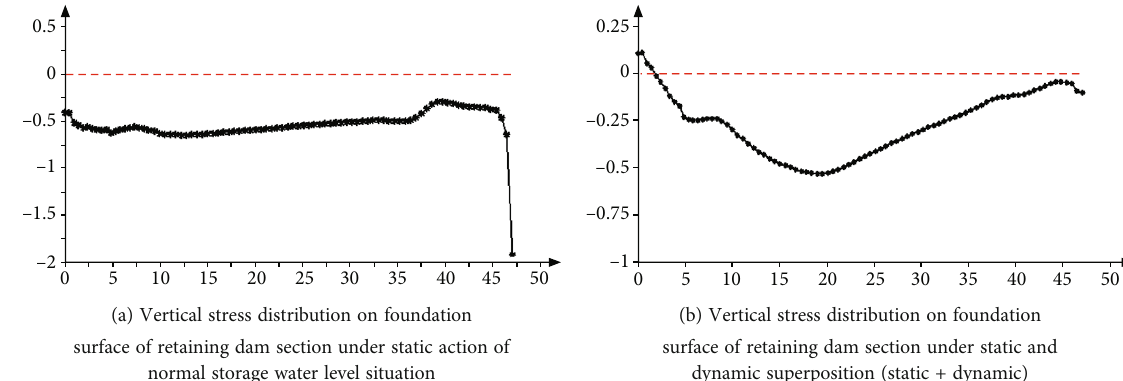
Figure 8: Vertical stress distribution on foundation surface of retaining dam section under di ff erent working